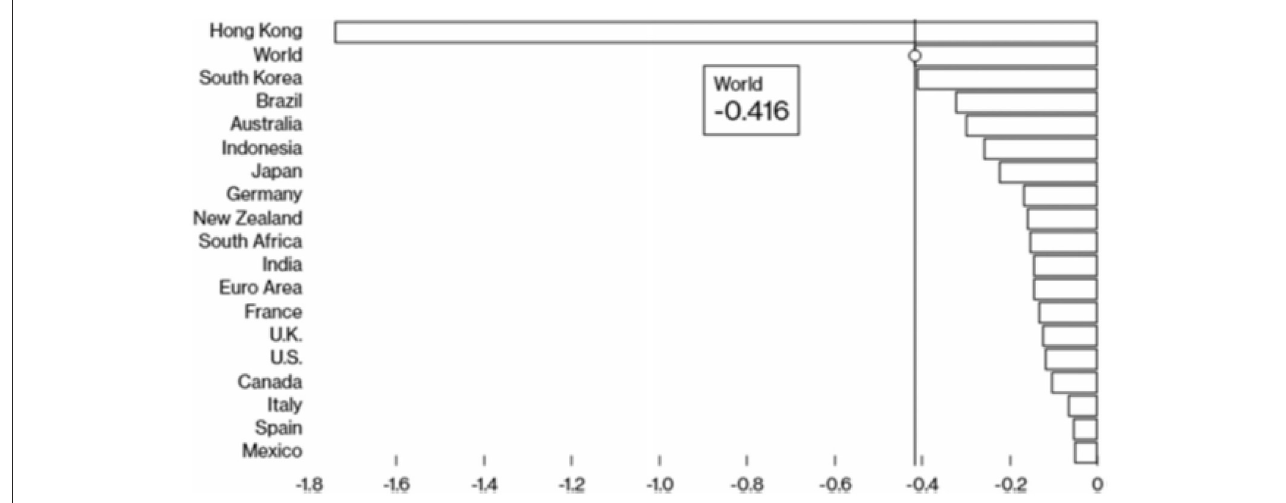
FIGURE2 Growth deviation in percentage points from Q1 2020. Source: Bloomberg